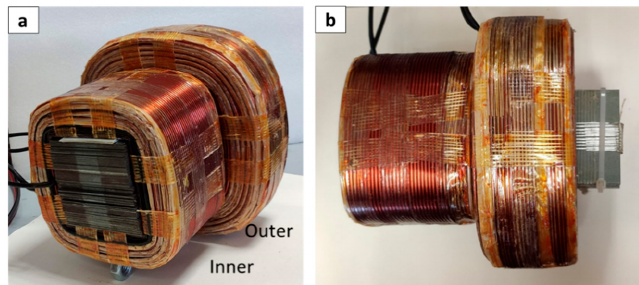
Figure 1. Electromagnet unit arrangement with the two coils (outer and inner) and the electrical steel core: ( a ) front view; ( b ) top view.